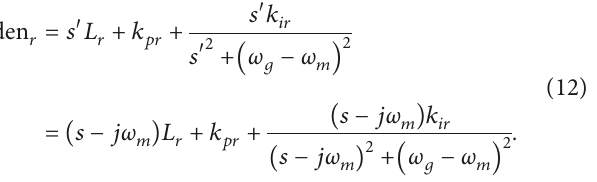
s with different k pg . eqg ( )